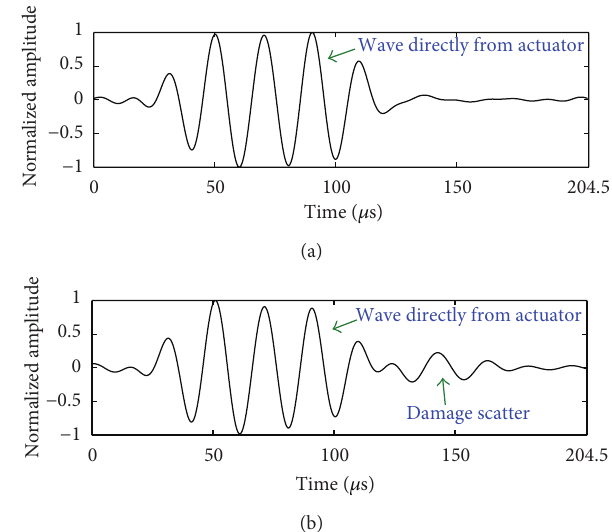
Figure 7: Typical Lamb wave signals collected on aluminum plate with a through-thickness hole: at (a) A8 and (b) A10.